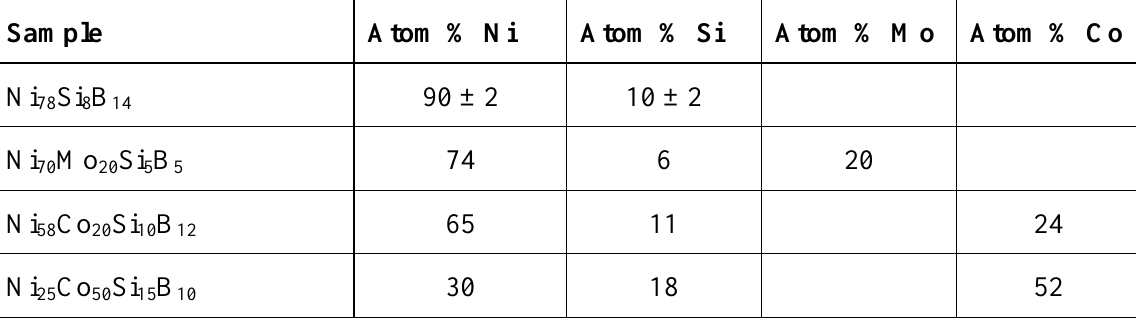
Table 1. EDS analysis of the different metallic glasses with Ni.